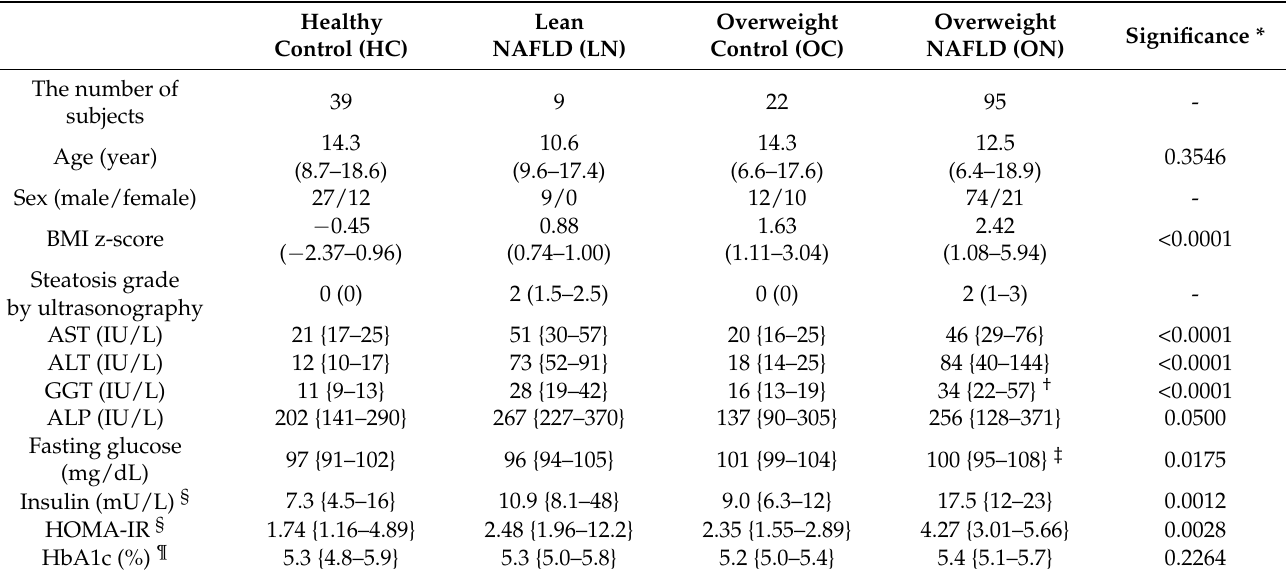
Table 1. Clinical characteristics of the study population according to the occurrence of obesity and